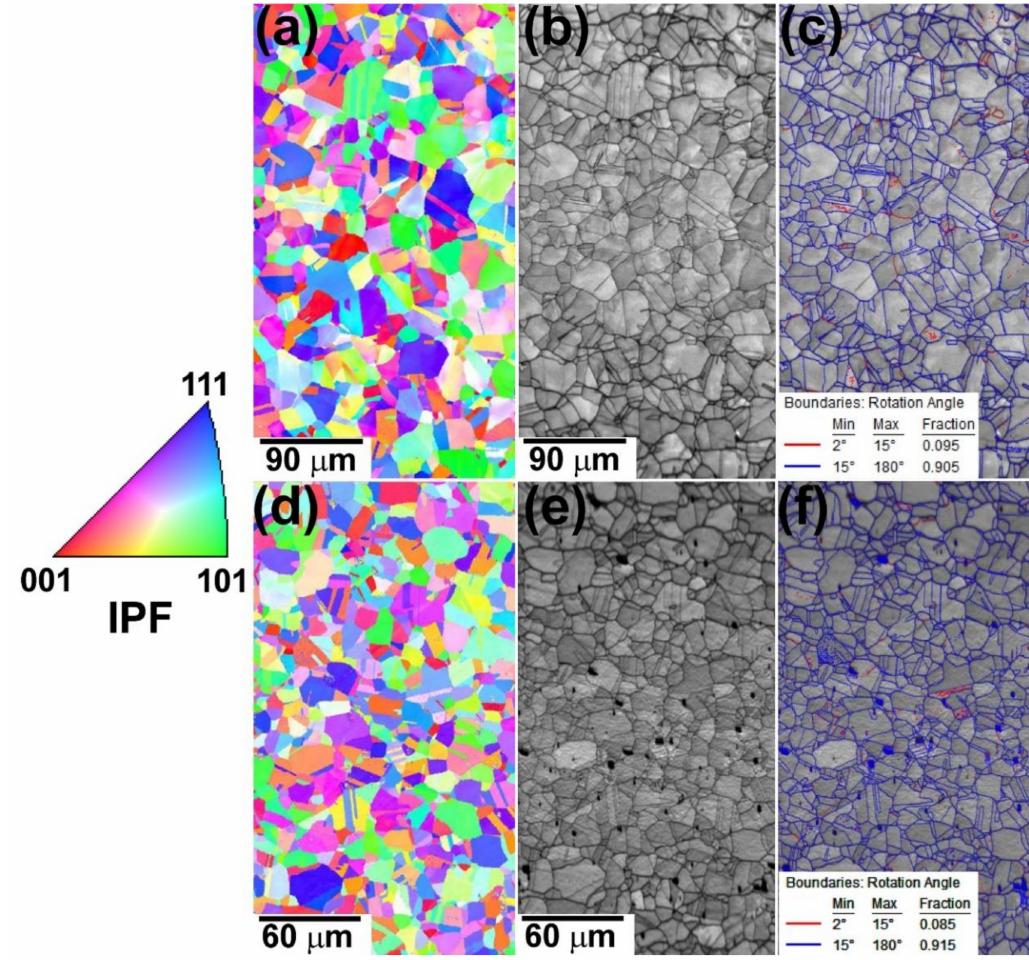
Figure 7. EBSD attained from samples reheated at 1200 ◦ C after the sixth pass and interpass time of 20 s, and water quenched after waiting for the interpass time to elapse following deformation interruption: ( a – c ) for F138 steel and ( d – f ) ISO steel, after reheating at 1200 ◦ C. Orientation imaging maps (color orientation indexation is shown in the inverse of pole figures (IPF) presented in respective insets): ( a , d ). IQ images: ( b , e ). Maps of the distribution of boundaries superimposed to respective IQ images, showing high-angle boundaries (misorientations θ > 15 ◦ , blue lines) and low-angle boundaries (subgrains, 2 ◦ < θ < 15 ◦ , red lines): ( c , f